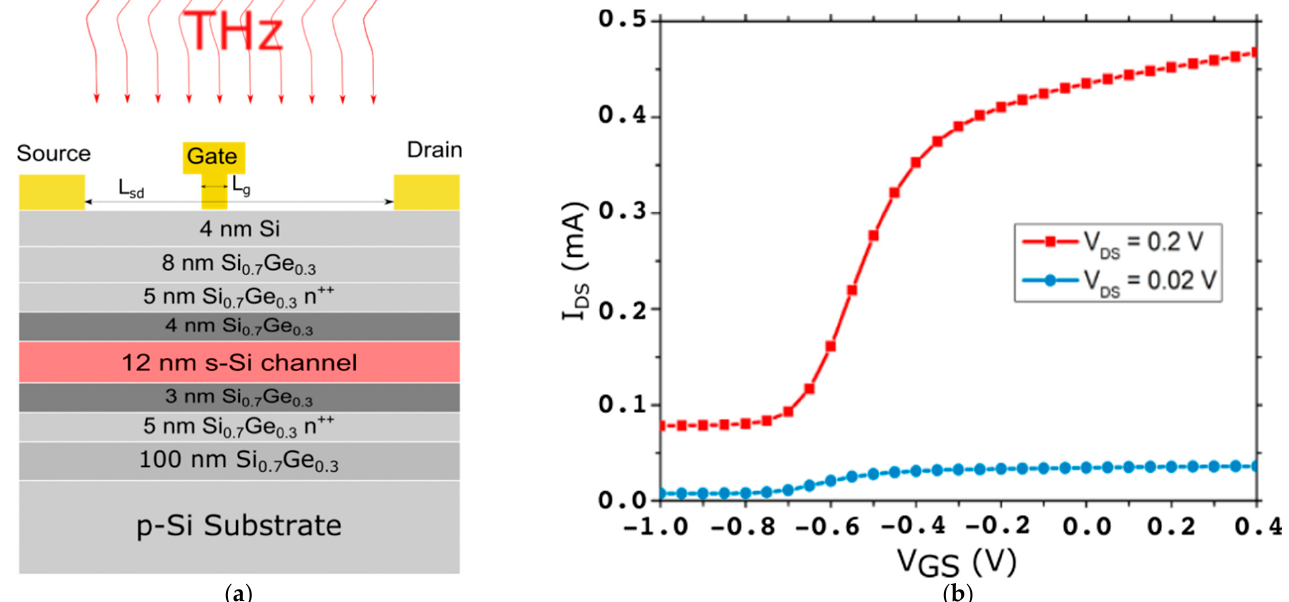
Figure 1. ( a ) Cross section of the Si/SiGe n-channel modulation-doped field-effect transistor (MODFETs) showing the vertical layout of the transistor with a schematic of the contacts. The strained-Si layer is highlighted in carnation color while the two supply layers are indicated with n ++ ; ( b ) measured transfer characteristics of the Si/SiGe n-channel MODFETs at two different values of the drain-to- source (V DS ) biases: 20 and 200 mV.